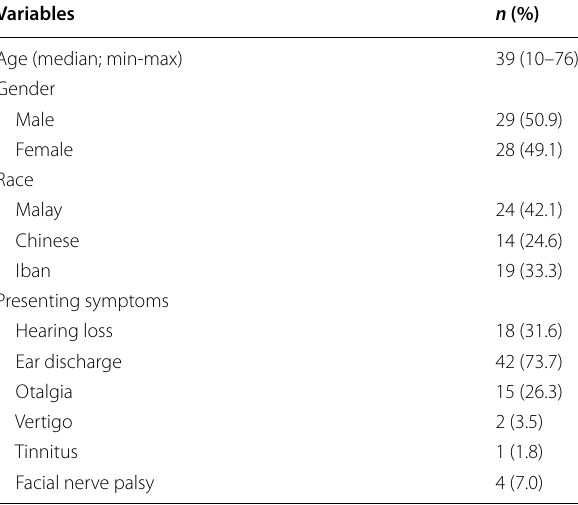
Table 1 Clinical characteristic of the patients